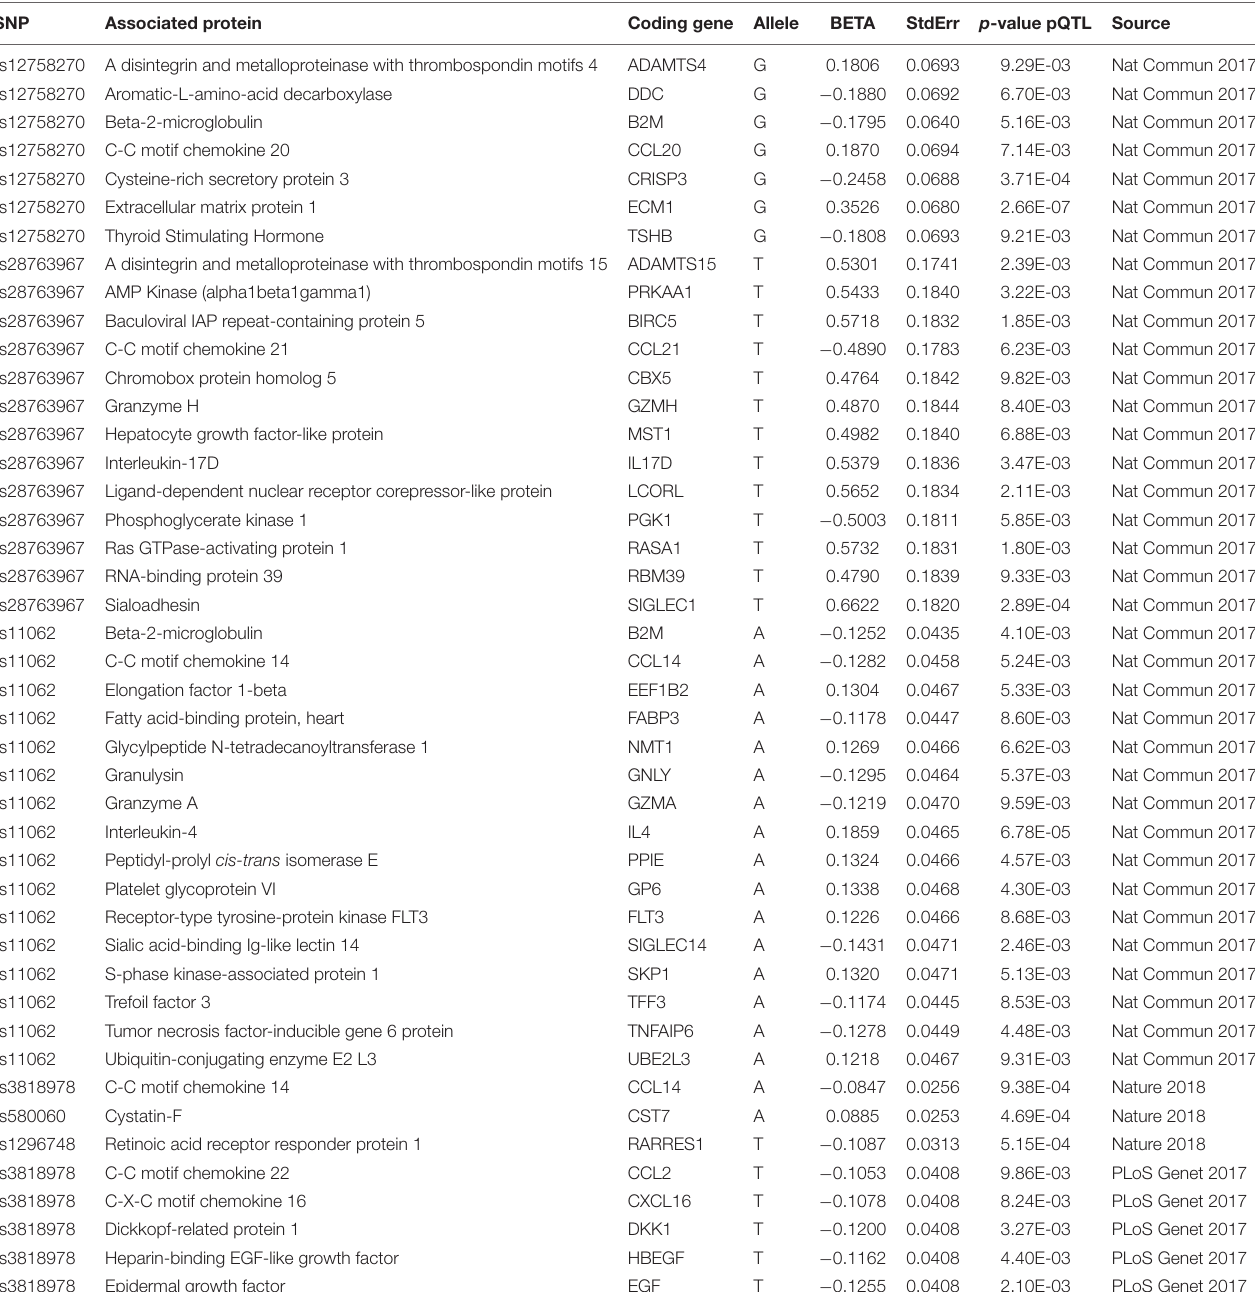
TABLE 3 | pQTL signals for the SCAD-associated RNA modification